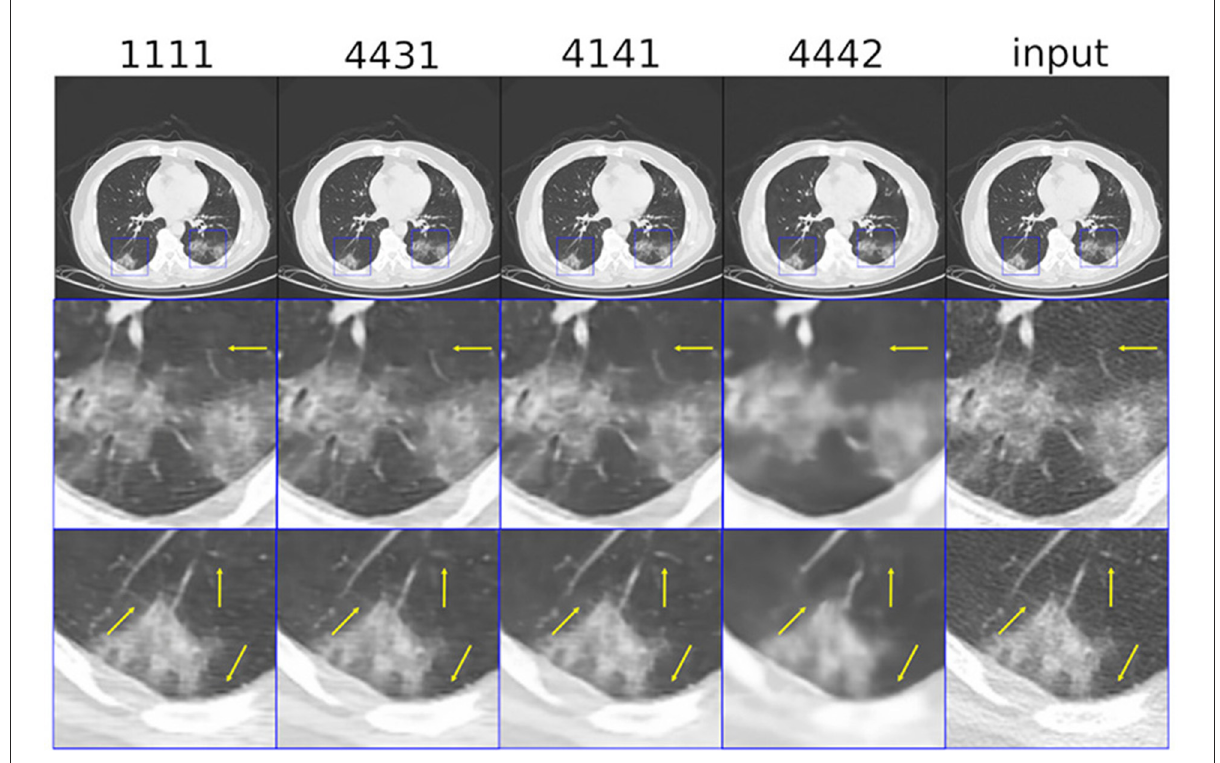
FIGURE13 Same details of the reconstruction CT image in different epochs for CT real